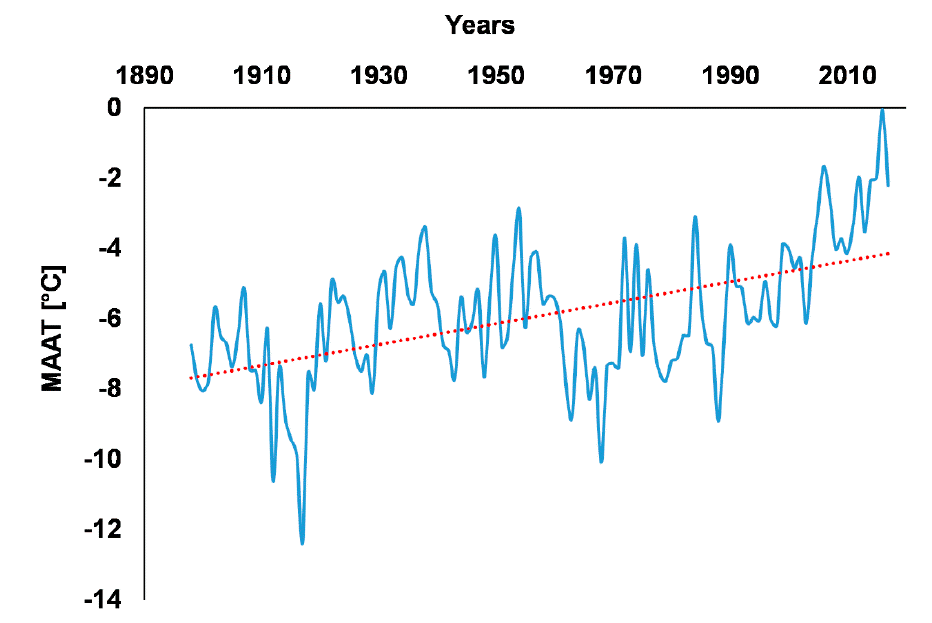
Figure 1. Mean annual air temperature (MAAT) at Svalbard Airport in the years 1898–2018, together with trend line [33].